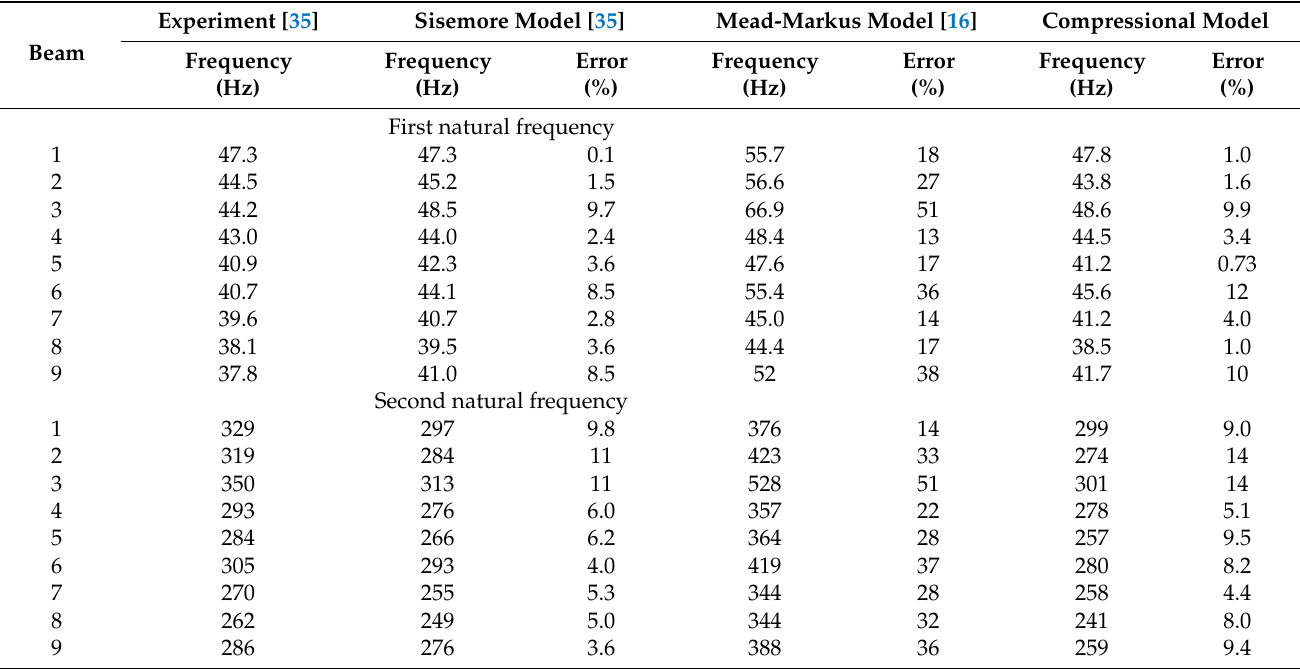
Table 6. Natural frequencies of the first two modes for cantilever EVES beams: comparison of experimental and calcu- lated